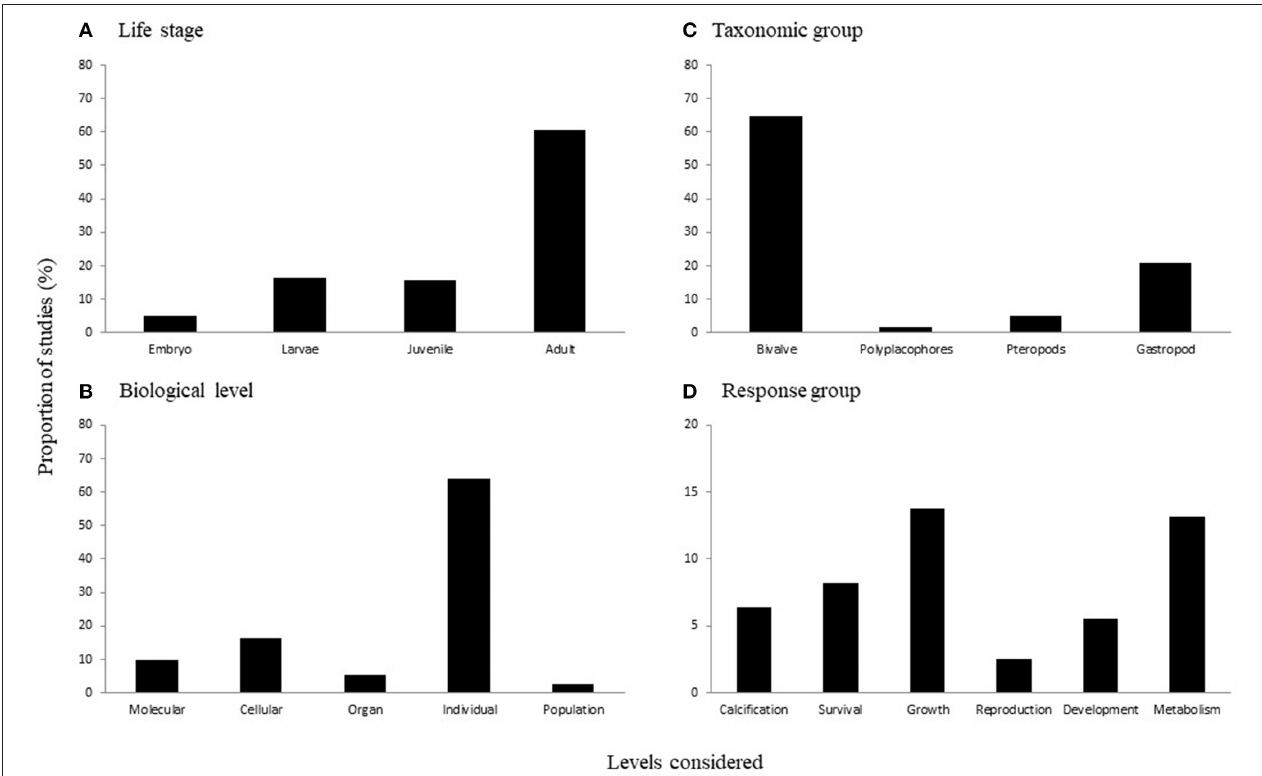
FIGURE 2 | The proportion of studies considering different levels of (A) life stages, (B) taxonomic groups, (C) biological levels, and (D) response variable groups. Note the difference in scale on the y-axis of (D)